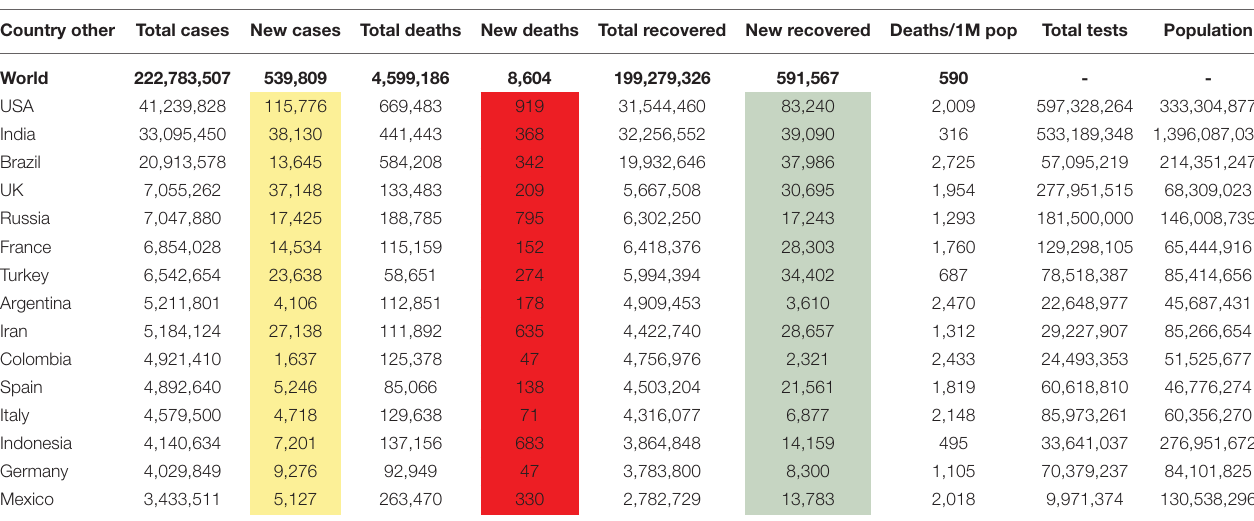
TABLE 4 | COVID-19 global cases in the most affected countries, as of September 10, 2021. Country other Total cases New cases Total deaths New deaths Total recovered New recovered Deaths/1M pop Total tests Population